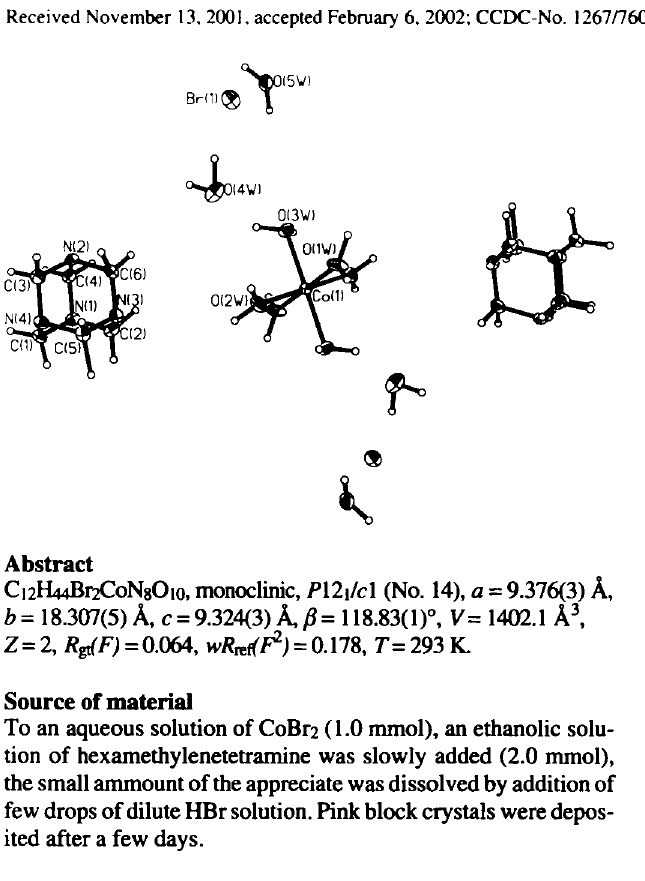
Table 1. Data collection and handling.